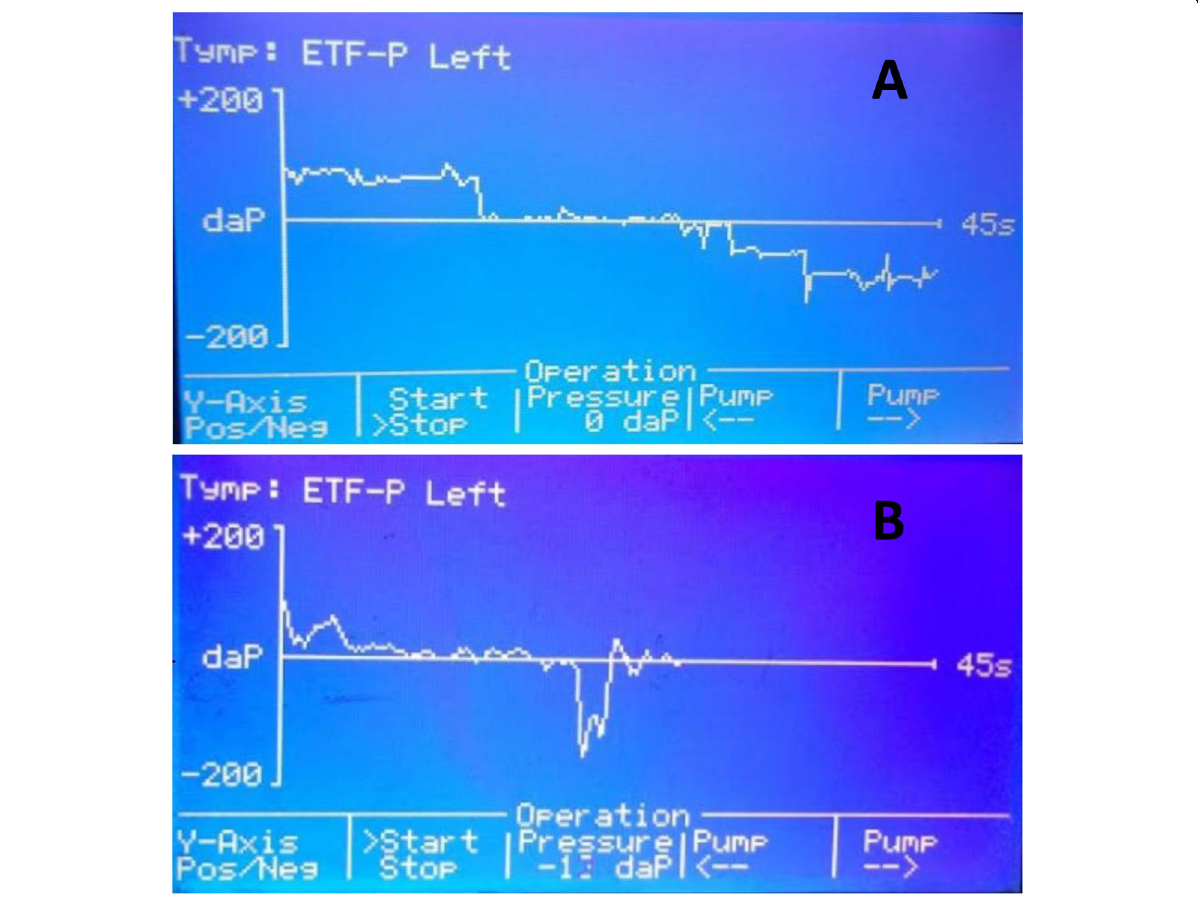
Fig. 1 Impedance audiometer showing step ladder graph in a case of ET function ( A ) and near flat curve with persistent pressure in a case of ET dysfunction ( B